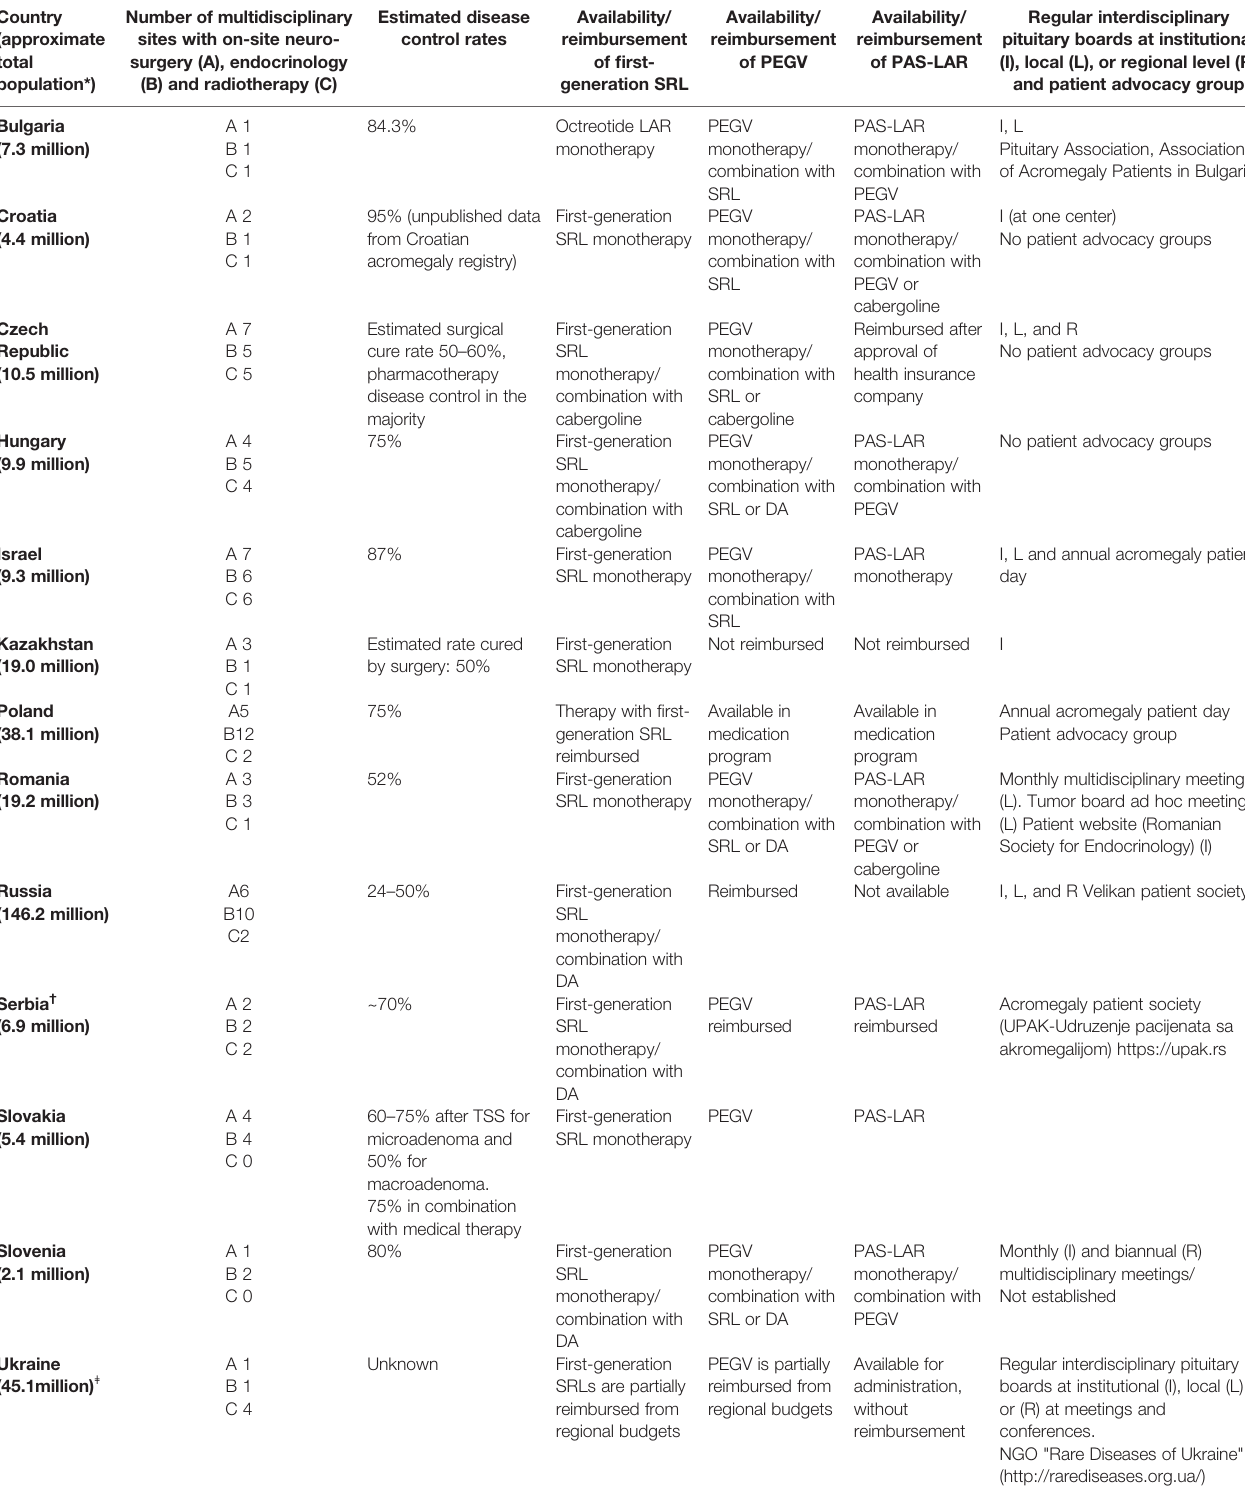
TABLE 3 | Multidisciplinary centers, treatment availability, and interdisciplinary pituitary boards according to the panel experts from CEE, Israel, and Kazakhstan. Country